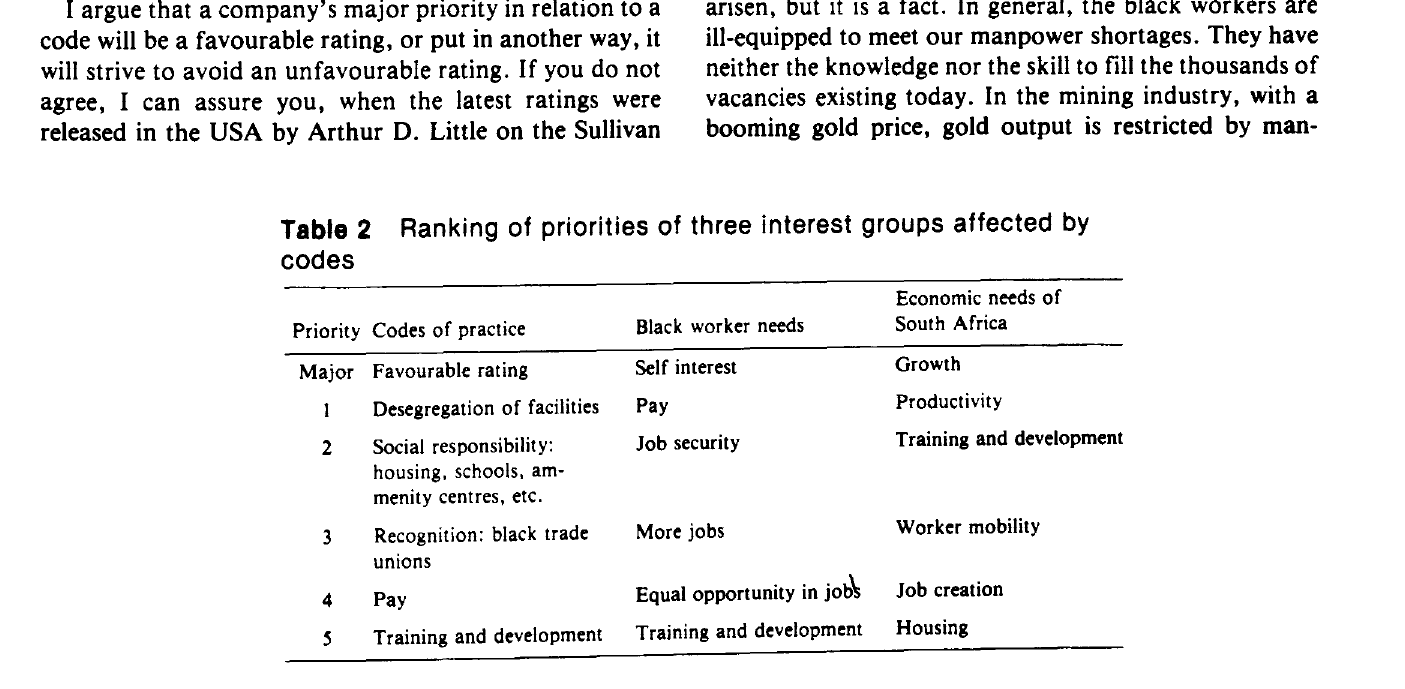
Ranking of priorities of three interest groups affected by